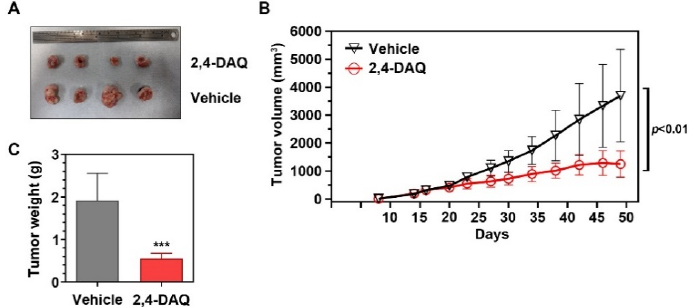
Figure 5. Effects of 2,4-DAQ on tumor volume and tumor weight in gastric cancer cells (MKN45) xenograft nude mice. ( A ) Representative images showing injected xenograft tumors in nude mice at Day 49 post subcutaneous injection. ( A , B ) tumor growth and ( C ) tumor weight evaluation of 2,4-DAQ vs. vehicle group. Symbol *** indicates p <